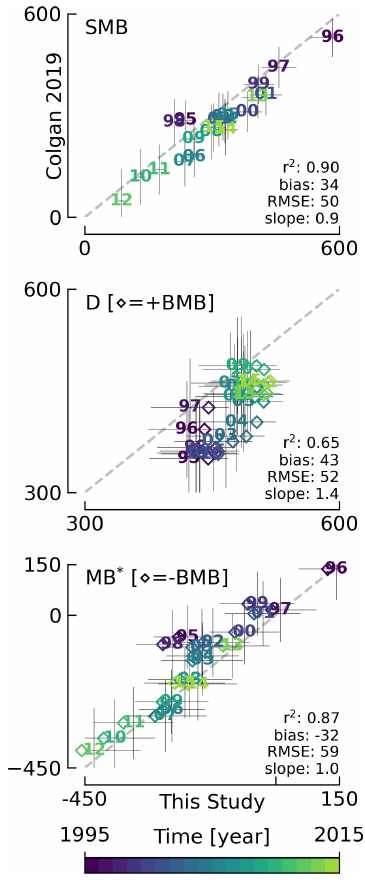
Figure 5. Comparison of This Study vs. Mouginot et al. (2019). All axis units are Gtyr − 1 . Plotted numbers represent the last two digits of the year. Matching colored diamonds show the data when BMB is added to This Study. Printed numbers ( r 2 , bias, RMSE, slope) compare values without BMB.